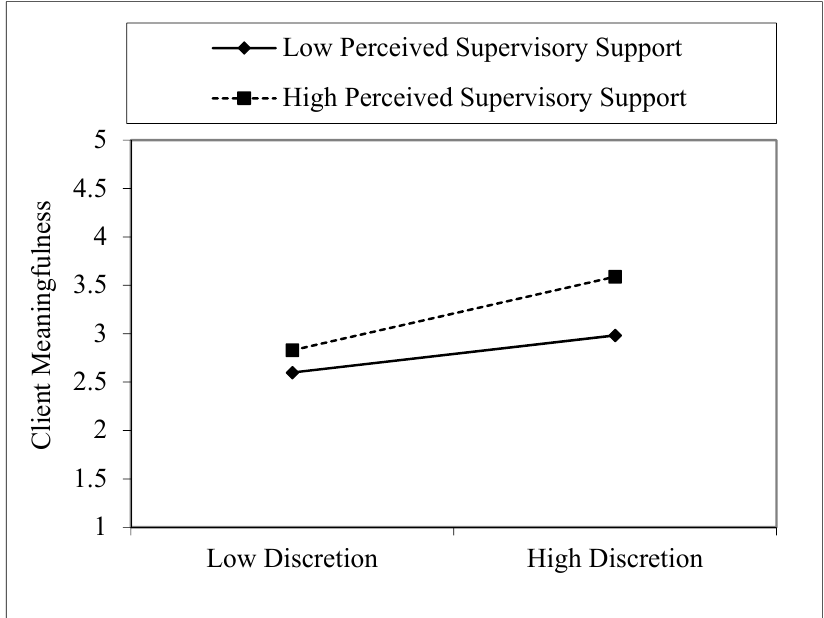
Figure 2. Interaction plot of discretion and perceived supervisory support on client meaningfulness.